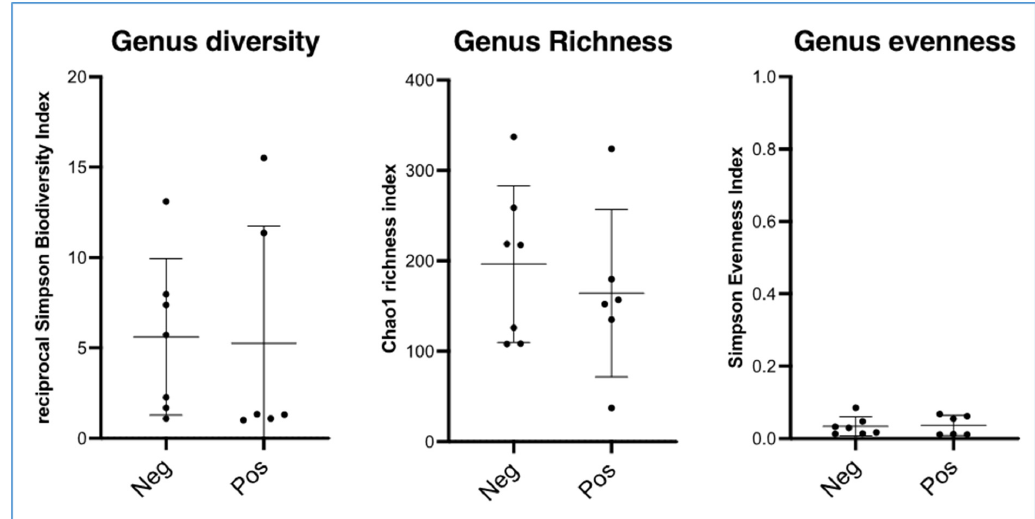
Figure 3. Alpha diversity, richness and regularity of bacterial genera in the surgical site during the caesarean section realisation in two groups of Belgian blue cows showing positive and negative bacterial culture. Data are scatter dot plots at the genus level for individual cows in the two defined groups with the mean and standard deviation.